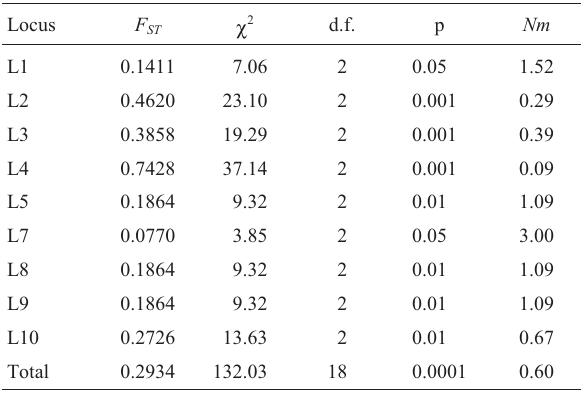
TableII -Amongpopulationdifferentiation( F ST )andgeneflowestimates ( Nm ) of RAPD allele frequencies for nine variable loci (L) from Hydromedusa maximiliani specimens inhabiting a drainage in the Parque Estadual de Carlos Botelho, state of São Paulo, southeastern Brazil. d.f.: degrees of